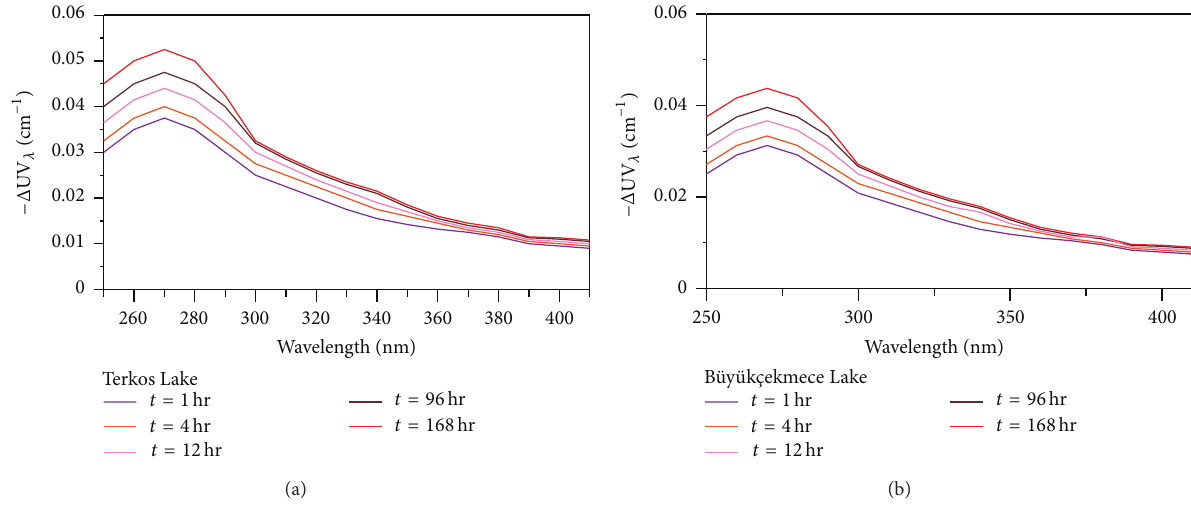
Figure 2: Differential spectra at varying reaction times and at pH 7 for (a) TL water samples and (b) BL water